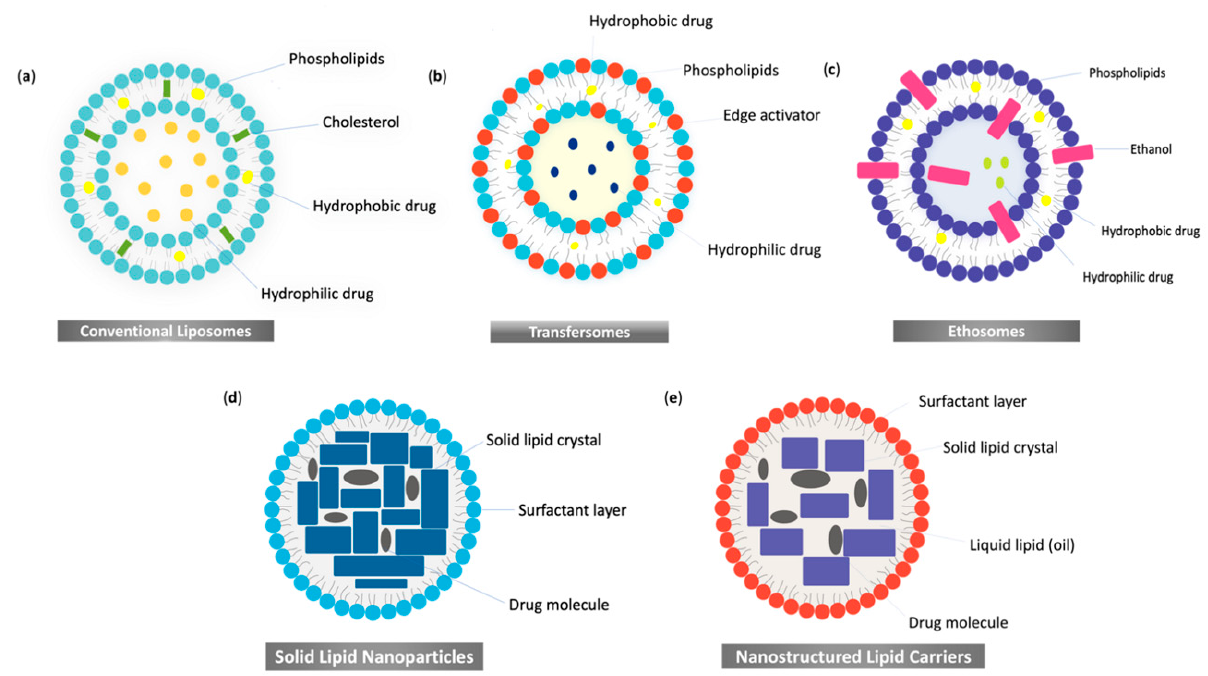
Figure 2. The structure of nanosized-lipid-based drug delivery systems applied in wound care: ( a ) conventional liposomes, ( b ) transfersomes, ( c ) ethosomes, ( d ) solid lipid nanoparticles and ( e ) nanostructured lipid carriers.